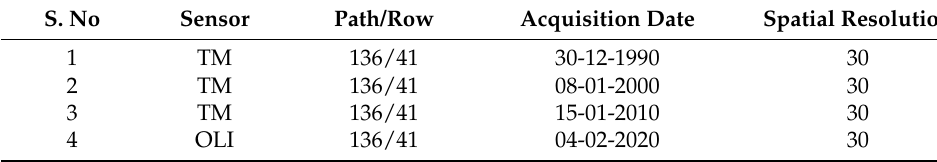
Table 1. Details of the satellite images used in the present study. S.